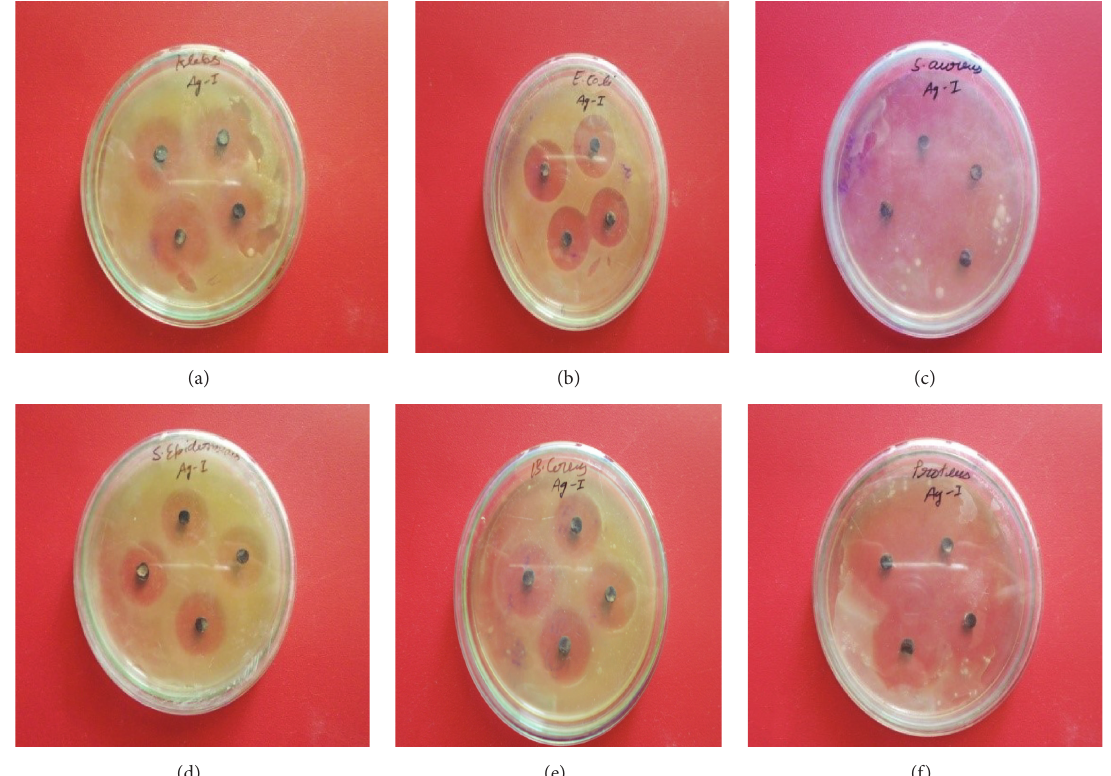
Figure 5: (a–f) Antibacterial activities of AgNPs against (a) Klebsiella pneumoniae , (b) Escherichia coli , (c) Staphylococcus aureus , (d) S.